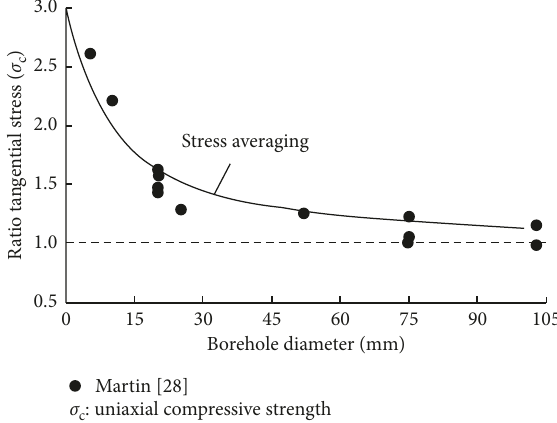
Figure 11: Tangential stress required to cause borehole